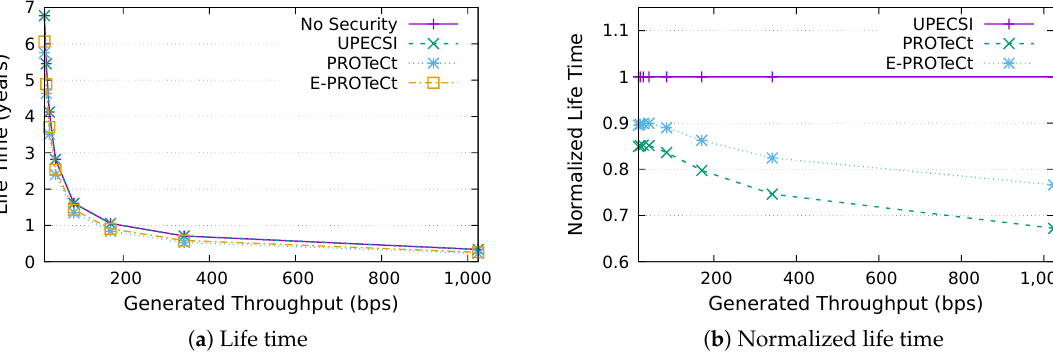
Figure 22. Life time analysis for an IoT network with 64